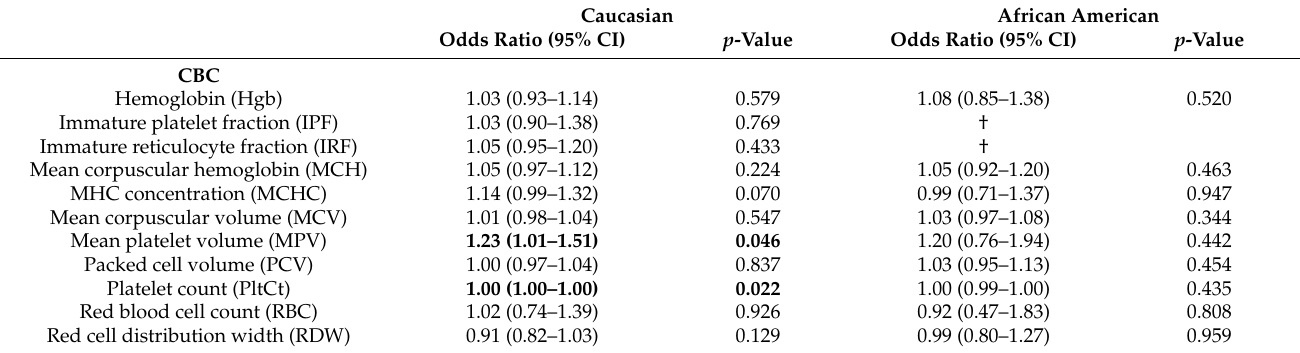
Table 3. Comparison of Hematological Profiles of RRMS/SPMS and PPMS